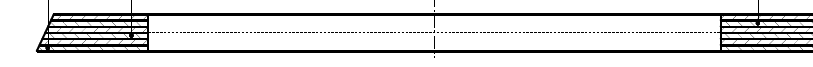
Figure 9. Schematic diagram of seal ring surface equivalence.